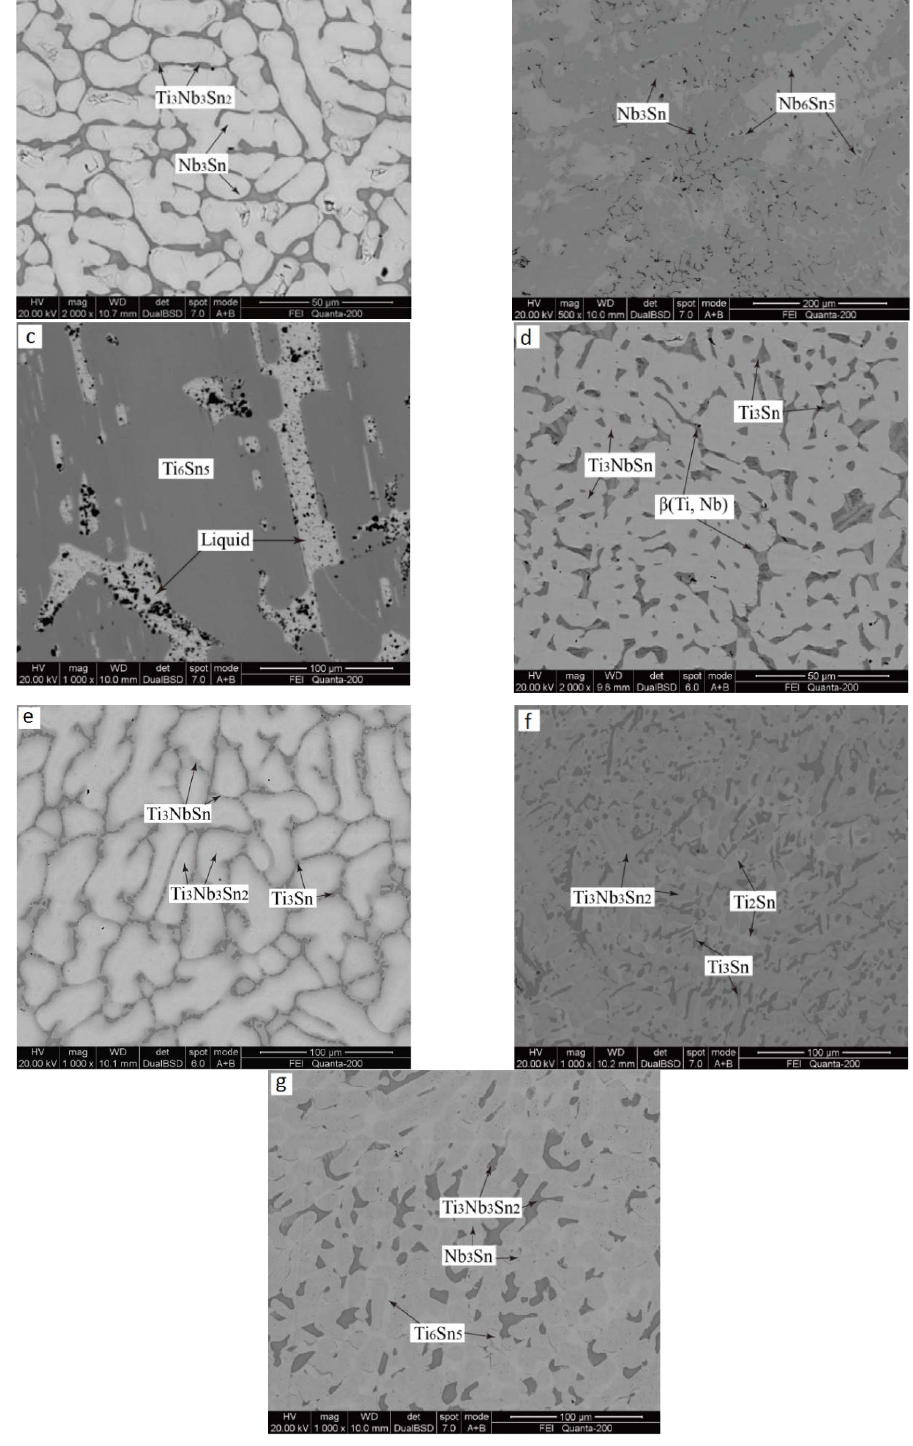
Figure 2. Microstructure of the typical alloys in Ti-Nb-Sn system annealed at 1173K for 1440 h. ( a ) Alloy 12; ( b ) Alloy 16; ( c ) Alloy 17; ( d ) Alloy 18; ( e ) Alloy 19; ( f ) Alloy 20; ( g ) Alloy 23. Figure 2c is the microstructure of Alloy 17 (Ti 32.0 Nb 17.3 Sn 50.7 ). It displays a bright gray phase liquid Sn with some holes and the gray matrix phase Ti 6 Sn 5 coexisted. It agrees with the XRD patterns of alloy 17 in Figure 3c. Figure 2d–g features the microstructure of three phase region alloys. Figure 2d is the microstructure of Alloy 18 (Ti 61.5 Nb 19.7 Sn 18.8 ). Two precipitates dark gray phase Ti 3 Sn and gray stripy phase β(Ti, Nb), as well as a bright gray matrix phase Ti 3 NbSn were observed. Figure 2e shows the microstructure of Alloy 19 (Ti 50.7 Nb 21.1 Sn 28.2 ). There are two solidification phases, gray reticular phase